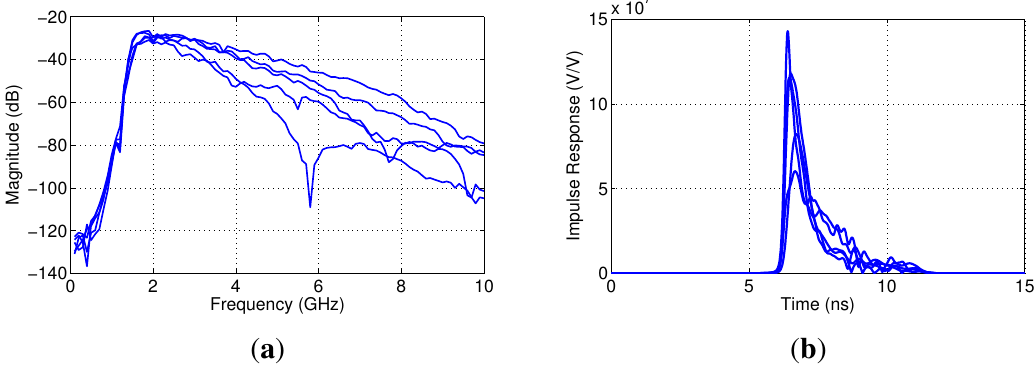
Figure 12. Measured transmission results between five sensor pairs for a recent participant. ( a ) Frequency domain; ( b ) time